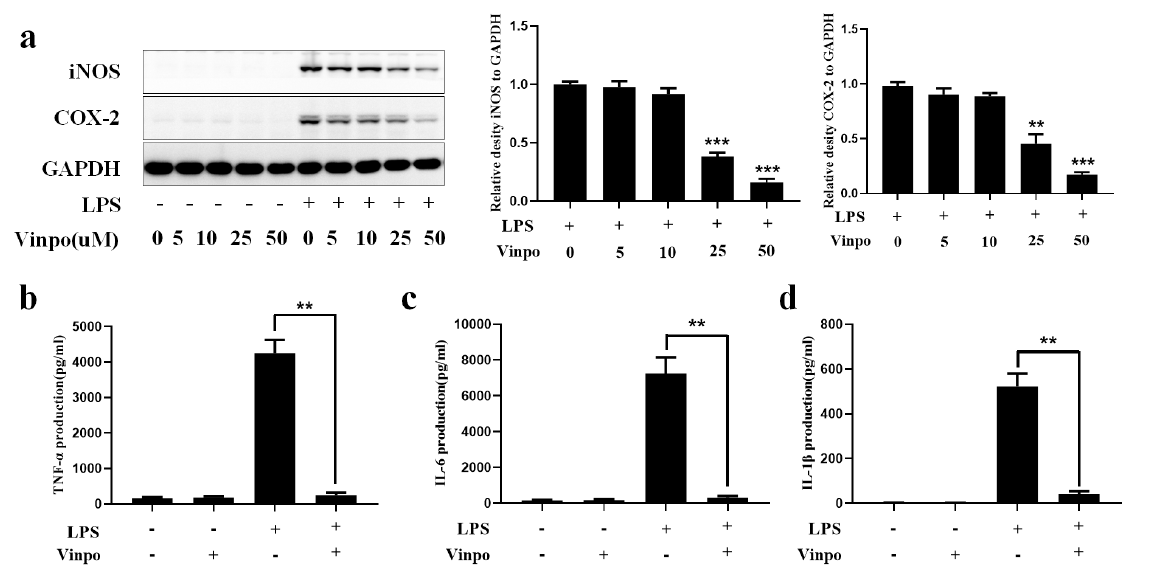
Figure 2. Vinpocetine suppressed the protein expression levels of the pro-inflammatory mediators in BV2 microglia stimulated with LPS. (a) BV2 cells were pretreated with different doses of vinpocetine (0-50 μM ) for 12 h and then exposed to LPS (100 ng/mL) for 24 h. Cell lysates were analyzed by Western blot for iNOS, COX-2 and GAPDH. The relative band intensity of iNOS and COX-2 to GAPDH were analyzed. (b-d) Supernatants were measured for the release of TNF-α, IL-6 and IL-1β by ELISA assays. Data are representative of three independent experiments. **P < 0.01, ***P < 0.001 compared between the indicated